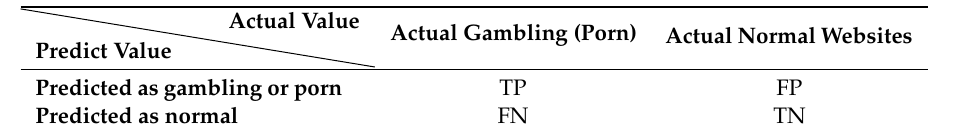
Table 2. The confusion matrix